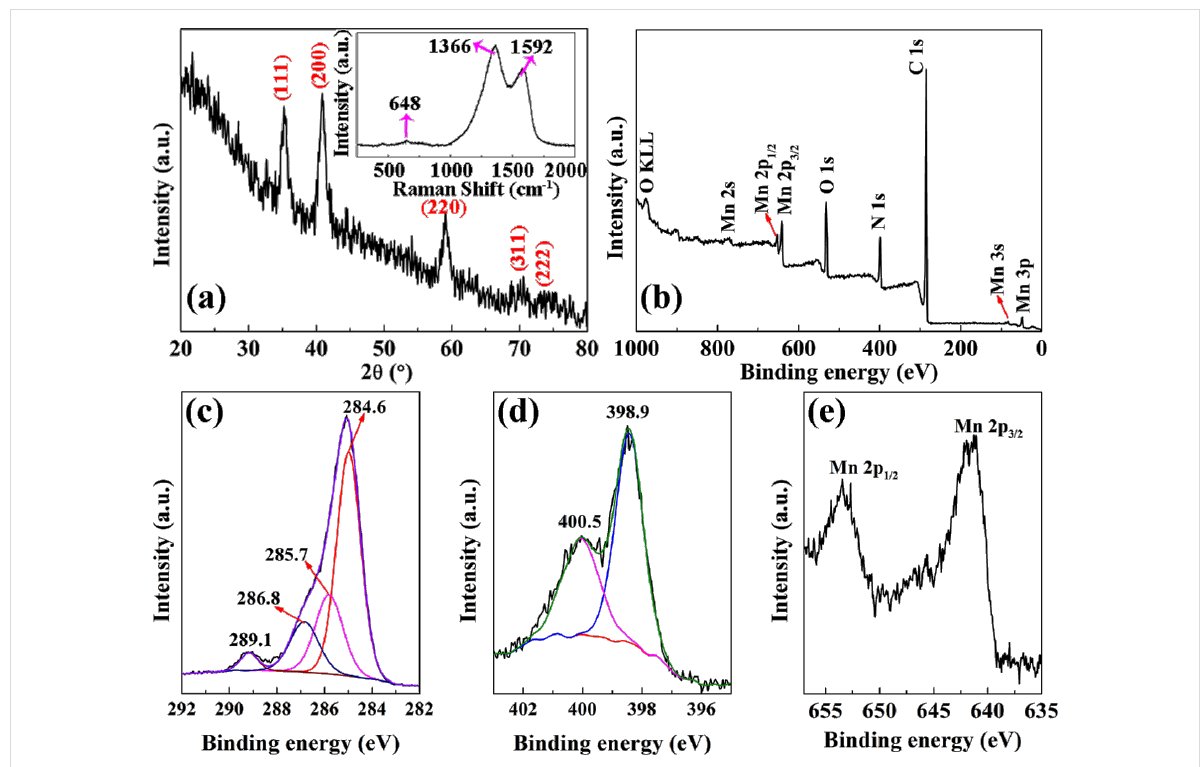
Figure 2: (a) XRD pattern and Raman spectrum (inset), (b) full scan XPS spectrum, (c–e) high-resolution XPS spectra of C 1s, N 1s, and Mn 2p of the spindle-like carbon nanofibers anchored with MnO and N.